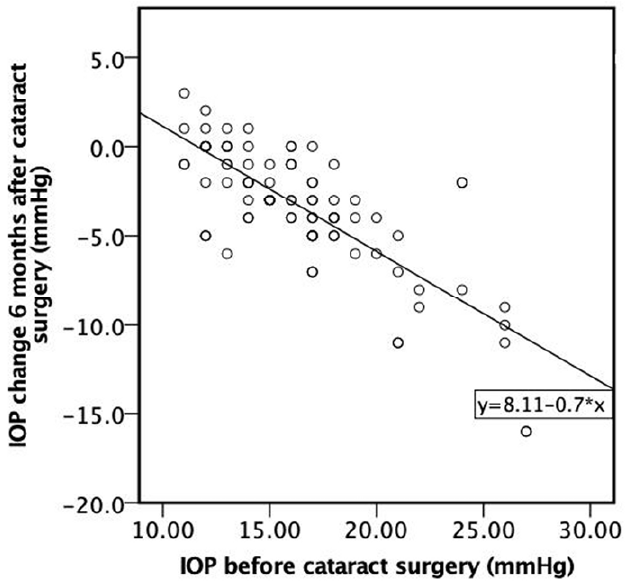
Figure 6. Correlation between IOP before cataract surgery and IOP change 6 months after cataract surgery.